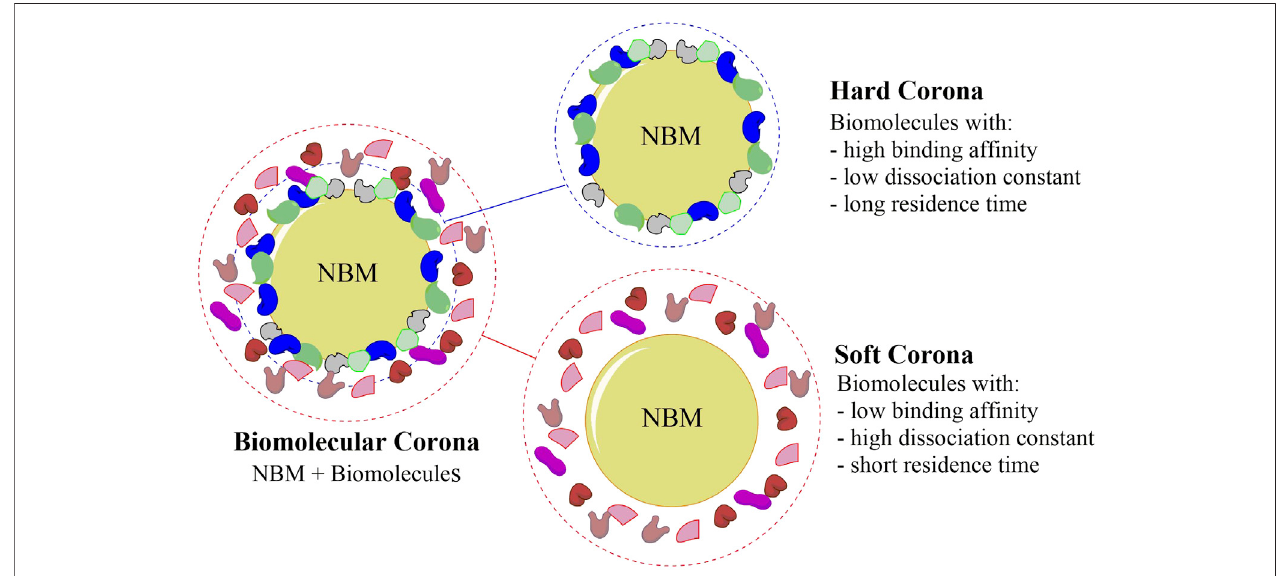
FIGURE 3 | Schematic representation of the biomolecular corona, showing the hard corona and the soft corona, that can confer a new biological identity to nanobiomaterials (NBMs). The hard corona is comprised of strongly bound biomolecules to the NBMs surface, whereas the soft corona is formed by weakly interacting